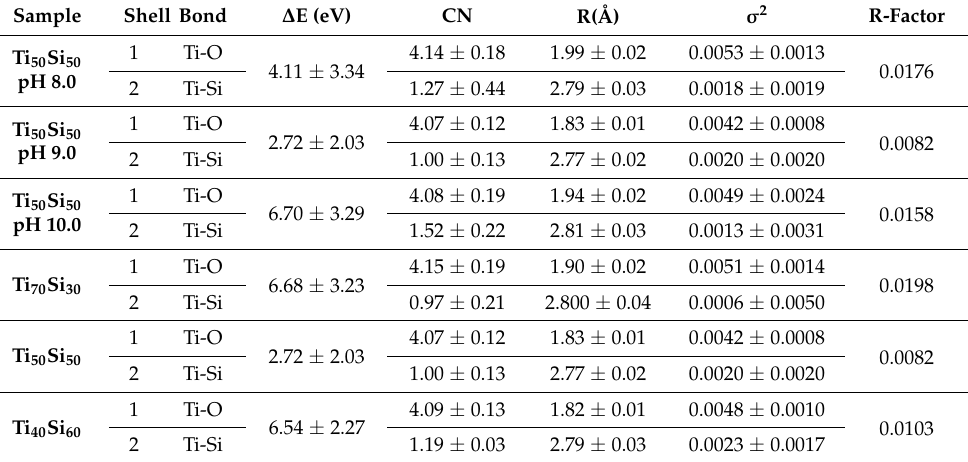
Table 3. Structural parameters (obtained from fittings of Ti K -edge EXAFS data) of first two coordina- tion shells around Ti atom of Ti and Si in Ti 50 Si 50 oxide synthesized at various pH values and Ti x Si y oxide synthesized at pH 9.0 with different Ti/Si